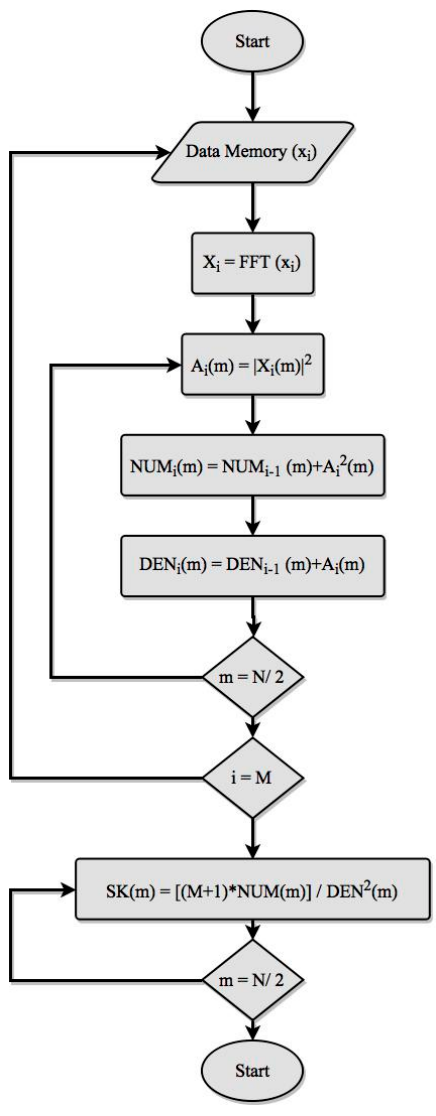
Figure 1. Spectral kurtosis algorithm flowchart .